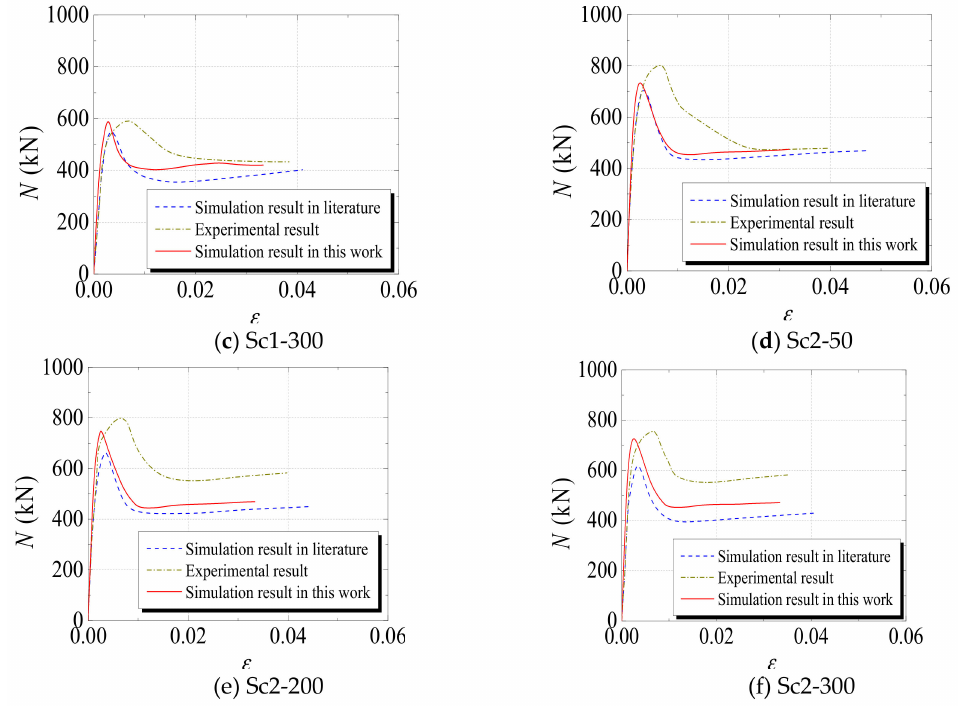
Figure 5. Comparisons between numerical results in this study and the results (both experimental and numerical) in